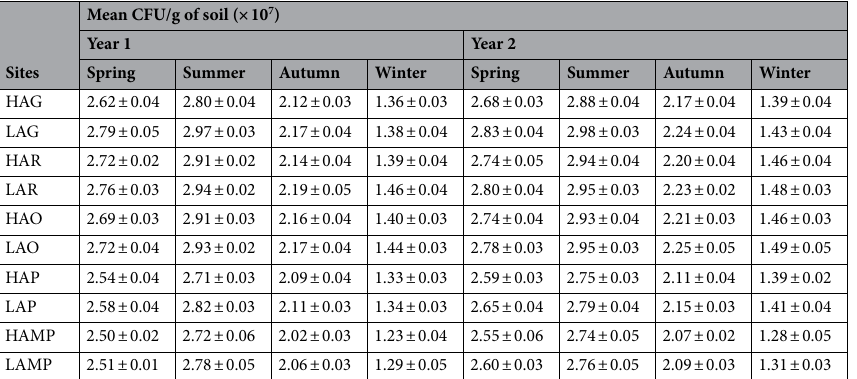
Table 4. Yearly seasonal variations in soil bacterial colony forming units (CFU) obtained from selected study sites in Dachigam National Park, Kashmir.